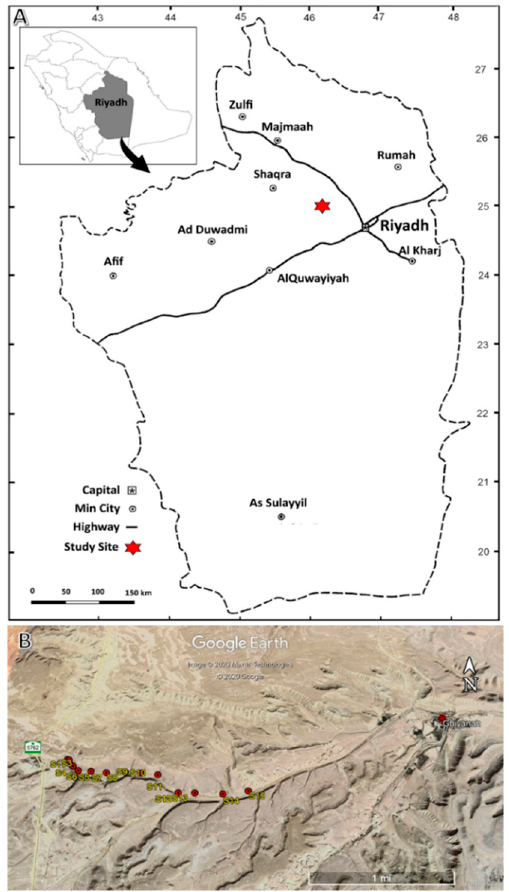
Figure 1. ( A ) Map of Riyadh region showing the study area indicated by star ( ★ ), ( B ) Google Earth map showing the sampled stands ( ● ).